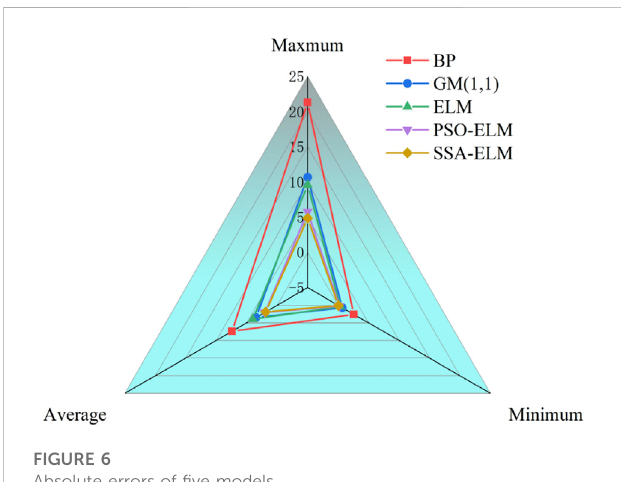
FIGURE 6 Absolute errors of fi ve models.